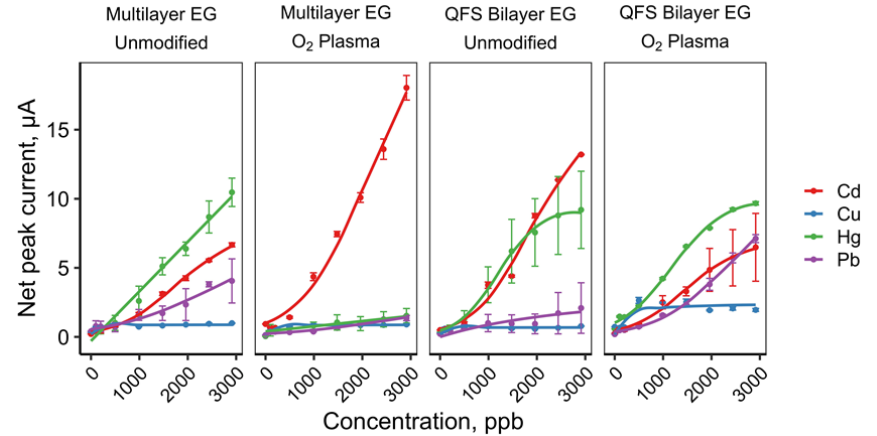
Figure 6. Dose–response curves (ppb in metal salt) for each type of EG and modification. Table 1. Fitting parameters of the dose–response for each